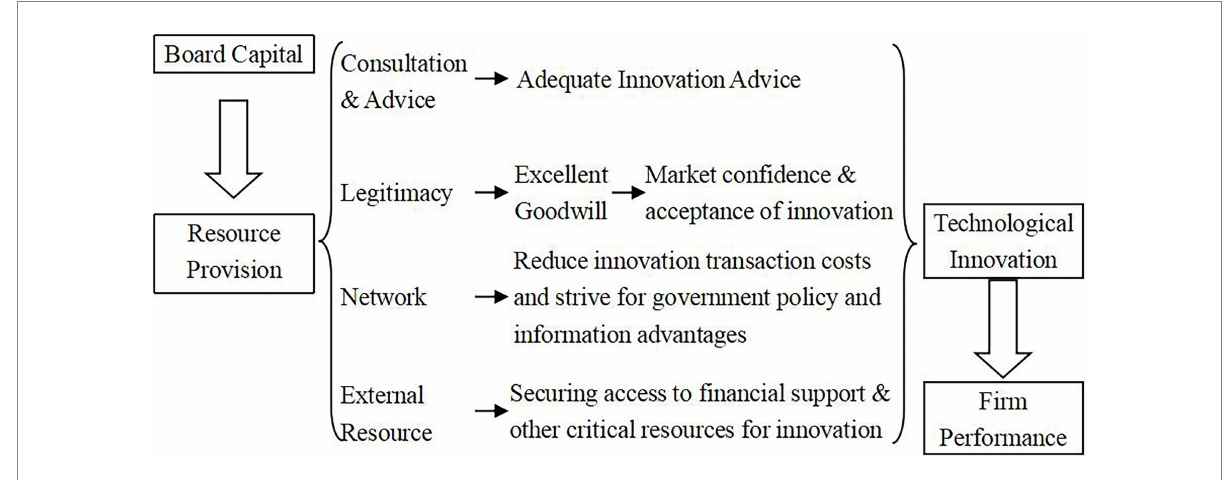
FIGURE 4 Theoretical analysis diagram of the main research variables.